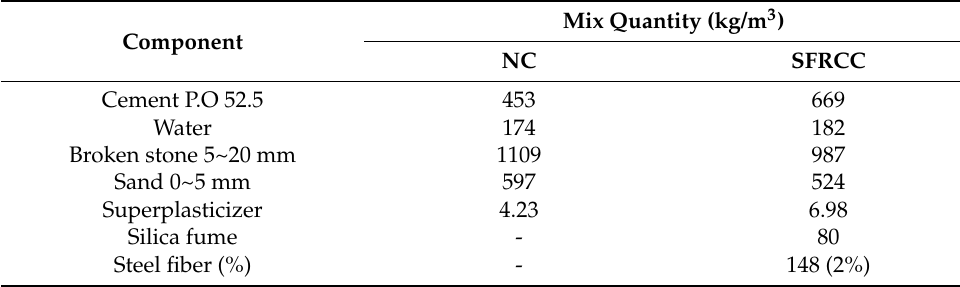
Table 1. The mixture proportions of concretes.